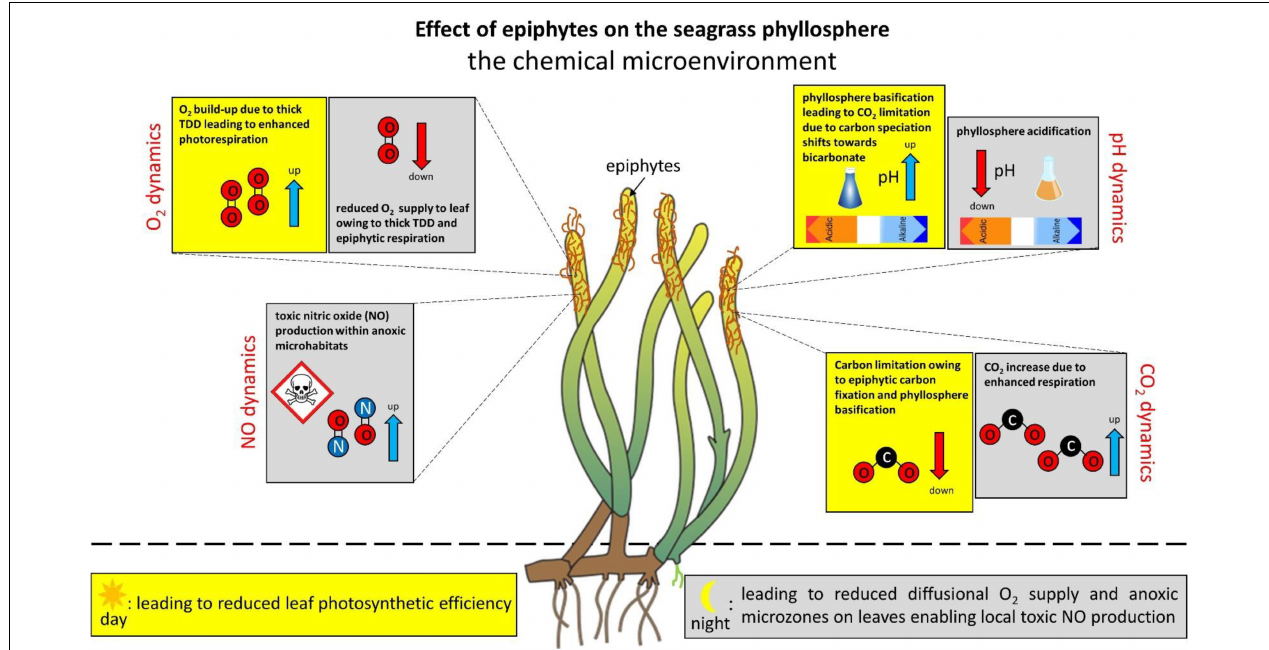
FIGURE 2 | Effect of epiphytes on the chemical microenvironment in the seagrass phyllosphere. The changes in the phyllosphere chemical microenvironment are shown as an effect on seagrass leaves with epiphytic biofilms as compared with bare leaves and/or bare leaf parts. The seagrass phyllopshere dynamics are shown over diel cycles, where the yellow marked areas represent alterations during daytime and gray marked areas represent changes during night-time. Blue arrows indicate an increase. Red arrows indicate a